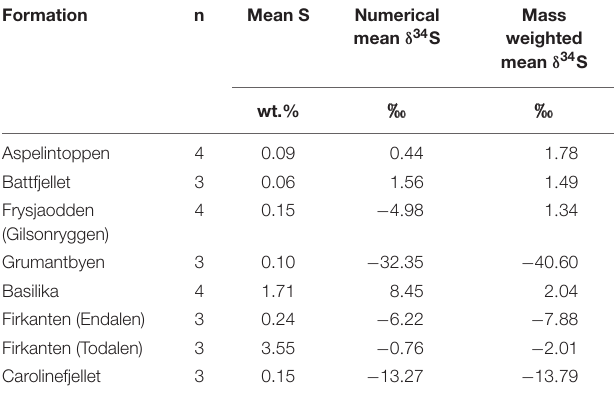
TABLE 5 | The mean quantity of sulfide (wt.%) in bedrock, the numerical mean sulfide δ 34 S